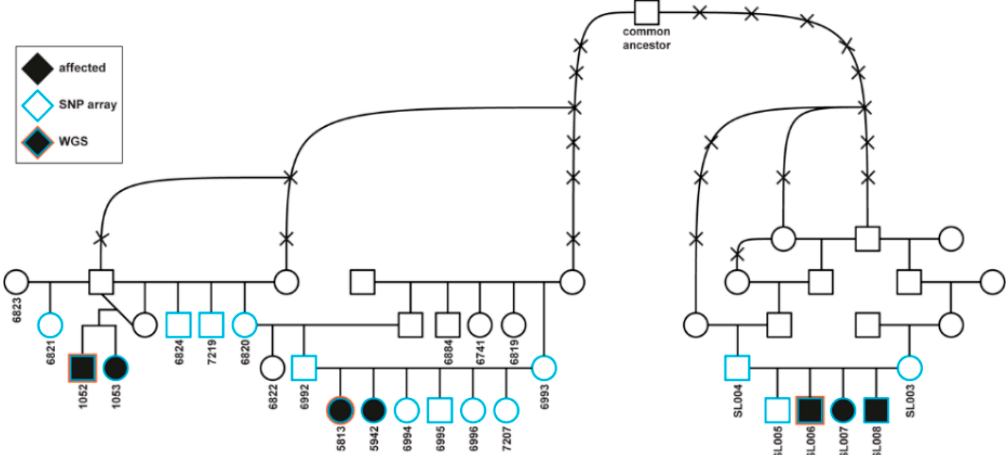
Figure 1. Pedigree of seven succinic semialdehyde dehydrogenase deficiency (SSADHD)-affected Saluki dogs. Females are depicted by circles and males by squares. Black fill indicates affected puppies. Numbers indicate 25 dogs from which samples were available. The blue contour indicates animals that were genotyped on SNP array, and the red contour the three affected dogs selected for the WGS. Note that the two litters on the left were seen in the USA and the third litter on the right in Germany. A common male ancestor illustrates the genealogical